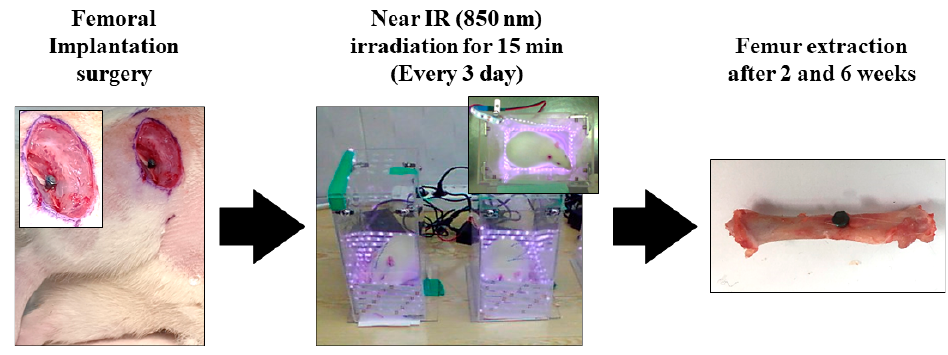
Figure 1. The experimental procedure of in vivo test.